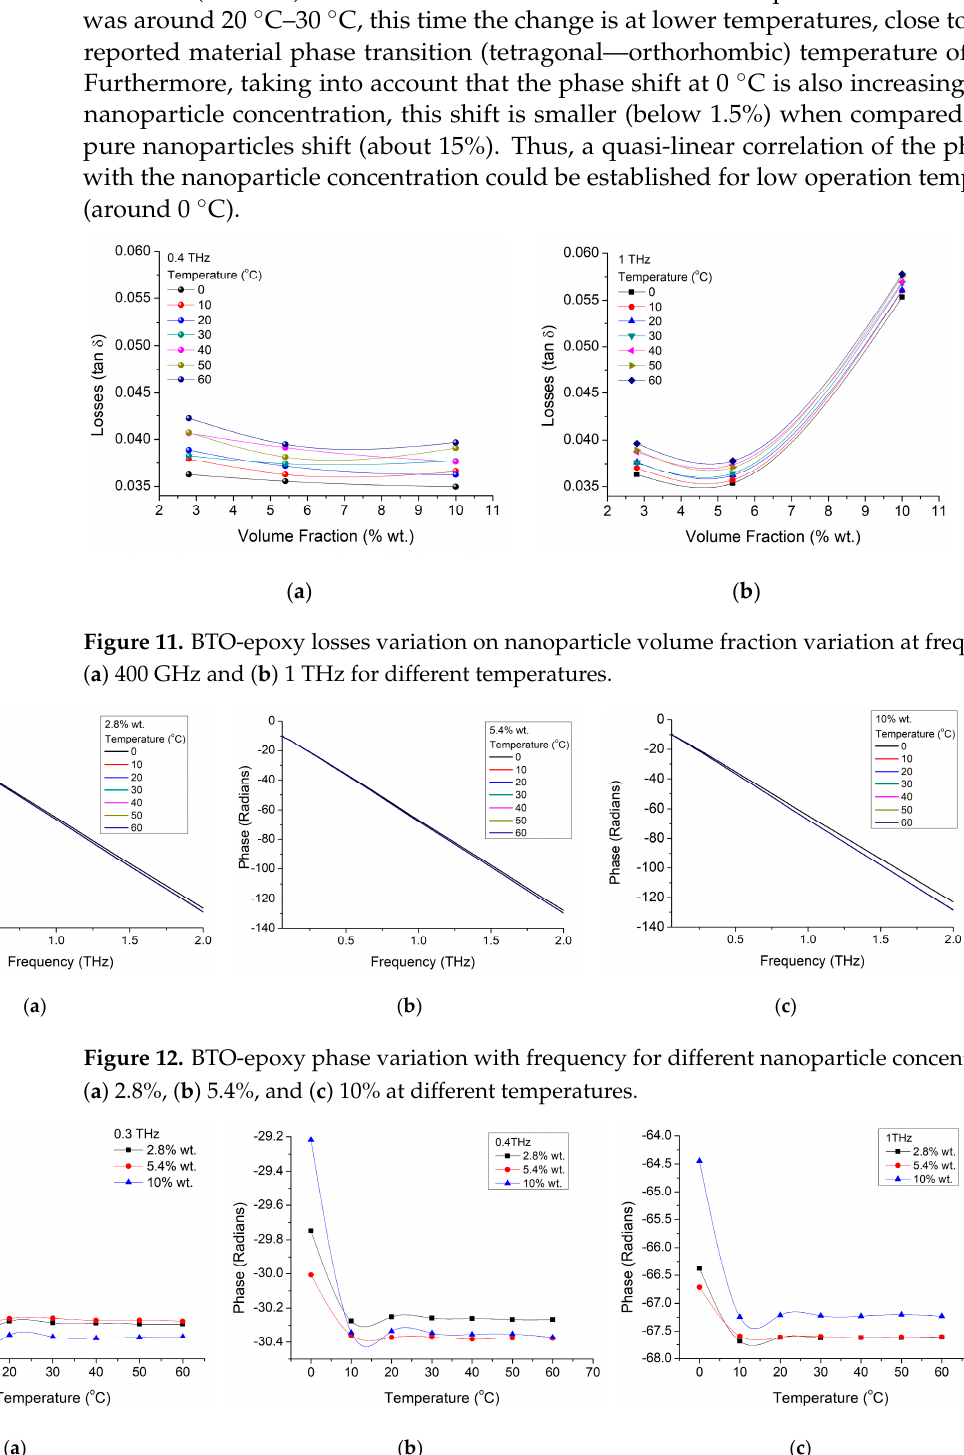
Figure 13. BTO-epoxy phase variation on temperature at different frequencies of ( a ) 300 GHz, ( b ) 400 GHz, and ( c ) 1 THz.